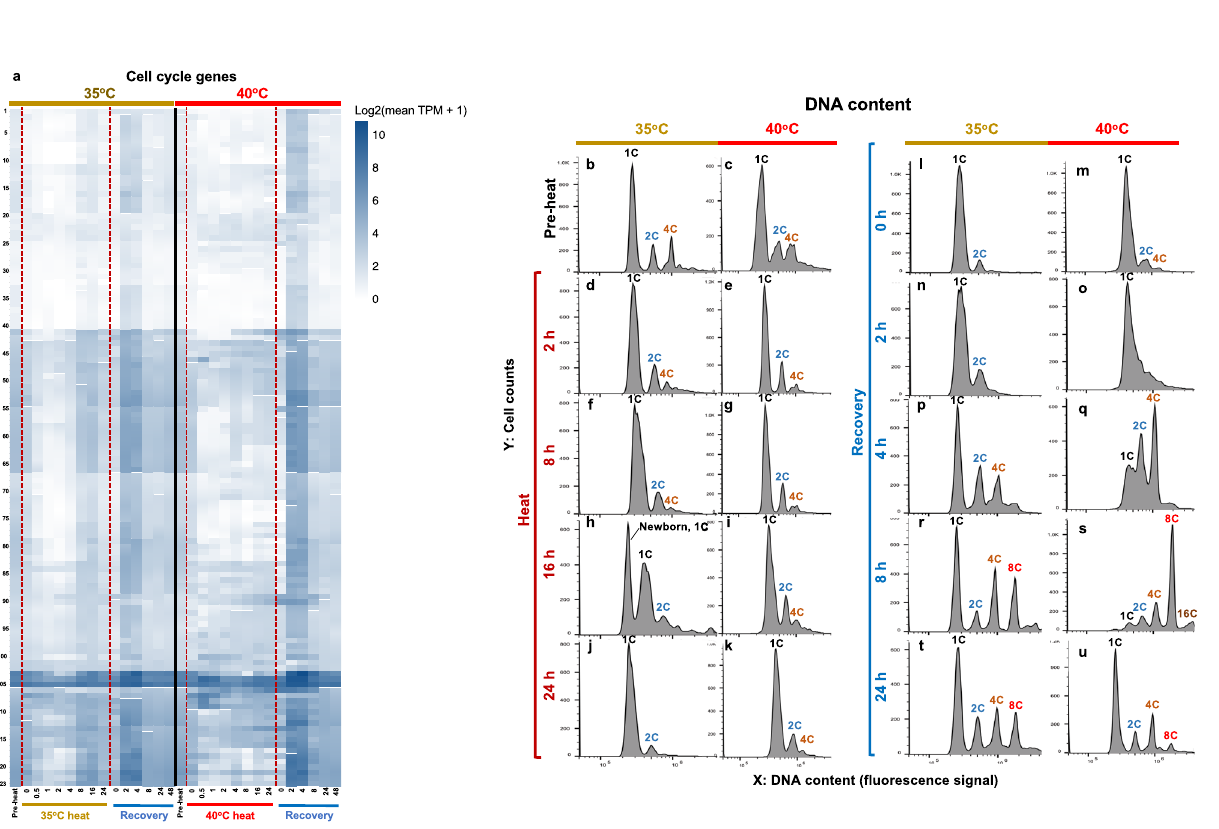
Fig. 3 Transcriptomic and proteomic network modeling revealed differential regulation of key biological pathways with treatments of 35°C or 40°C. a Weighted correlation network analysis (WGCNA) of transcriptome data identi fi ed gene modules with similar expression patterns. TM: transcriptomic module. The z-normalized consensus gene expression patterns for 40°C (red triangle) and 35°C (brown circle) for each module are displayed. b Correlation networks of protein abundance over time courses for 35°C and 40°C heat treatments. PM, proteomic module. For each module, the eigenvectors as aggregated signal shape is depicted. Prominent functional terms that were enriched in the respective module are given for proteins correlating positively (PM_a) or negatively (PM_b) to their corresponding eigenvector (FDR < 0.05). a , b Black vertical lines indicate the start and end of the heat treatment at either 35°C or 40°C. Pre-heat, before heat treatments. Time points during heat: 0 h, reach high temperature of 35°C or 40°C; 0.5 h, heat at 35°C or 40°C for 0.5 h, similar names for other time points during heat. Time points during recovery: 0 h, reach control temperature of 25°C for recovery after heat; 2 h, recovery at 25°C for 2 h, similar names for other time points during recovery. The y axes are in arbitrary units. Background shading indicates consensus expression pattern ± sd of eigenmodule members. The number at the top of each facet (e.g., TM1: 628, PM1_a:148) represents the total number of genes/proteins signi fi cantly associated with the given module (ANOVA, FDR < 0.05, genes/proteins can only belong to a single module). Select statistically signi fi cantly enriched MapMan functional terms are displayed in each facet. Ratios after each MapMan term (e.g., heat stress, 26/47) represent the number of genes/proteins with the assigned MapMan term in the given module relative to the number of genes/proteins with the assigned MapMan term in our entire dataset. Pie charts show the fraction of genes/proteins associated with the given module that have at least one assigned MapMan functional term (green) relative to those associated with the given module but without MapMan functional terms (white). Full functional enrichment analysis can be found in Supplementary Data 5 and 7.